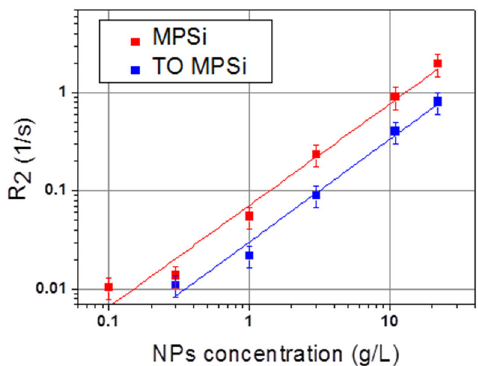
Figure 39. Transverse relaxation rate of aqueous suspensions of as-prepared (red squares) and thermally oxidized in air (blue squares) NPs prepared from MPSi versus NPs concentration. Solid lines are linear fits. (Reprinted from Reference [96] by permission from John Wiley and Sons © 2018).